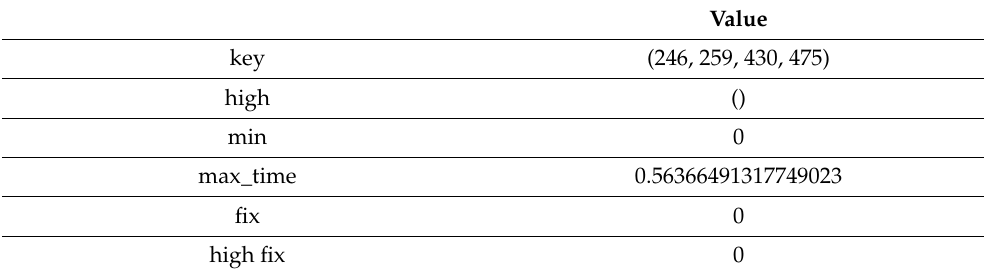
Table 11. Signature extracted by DESEND+.